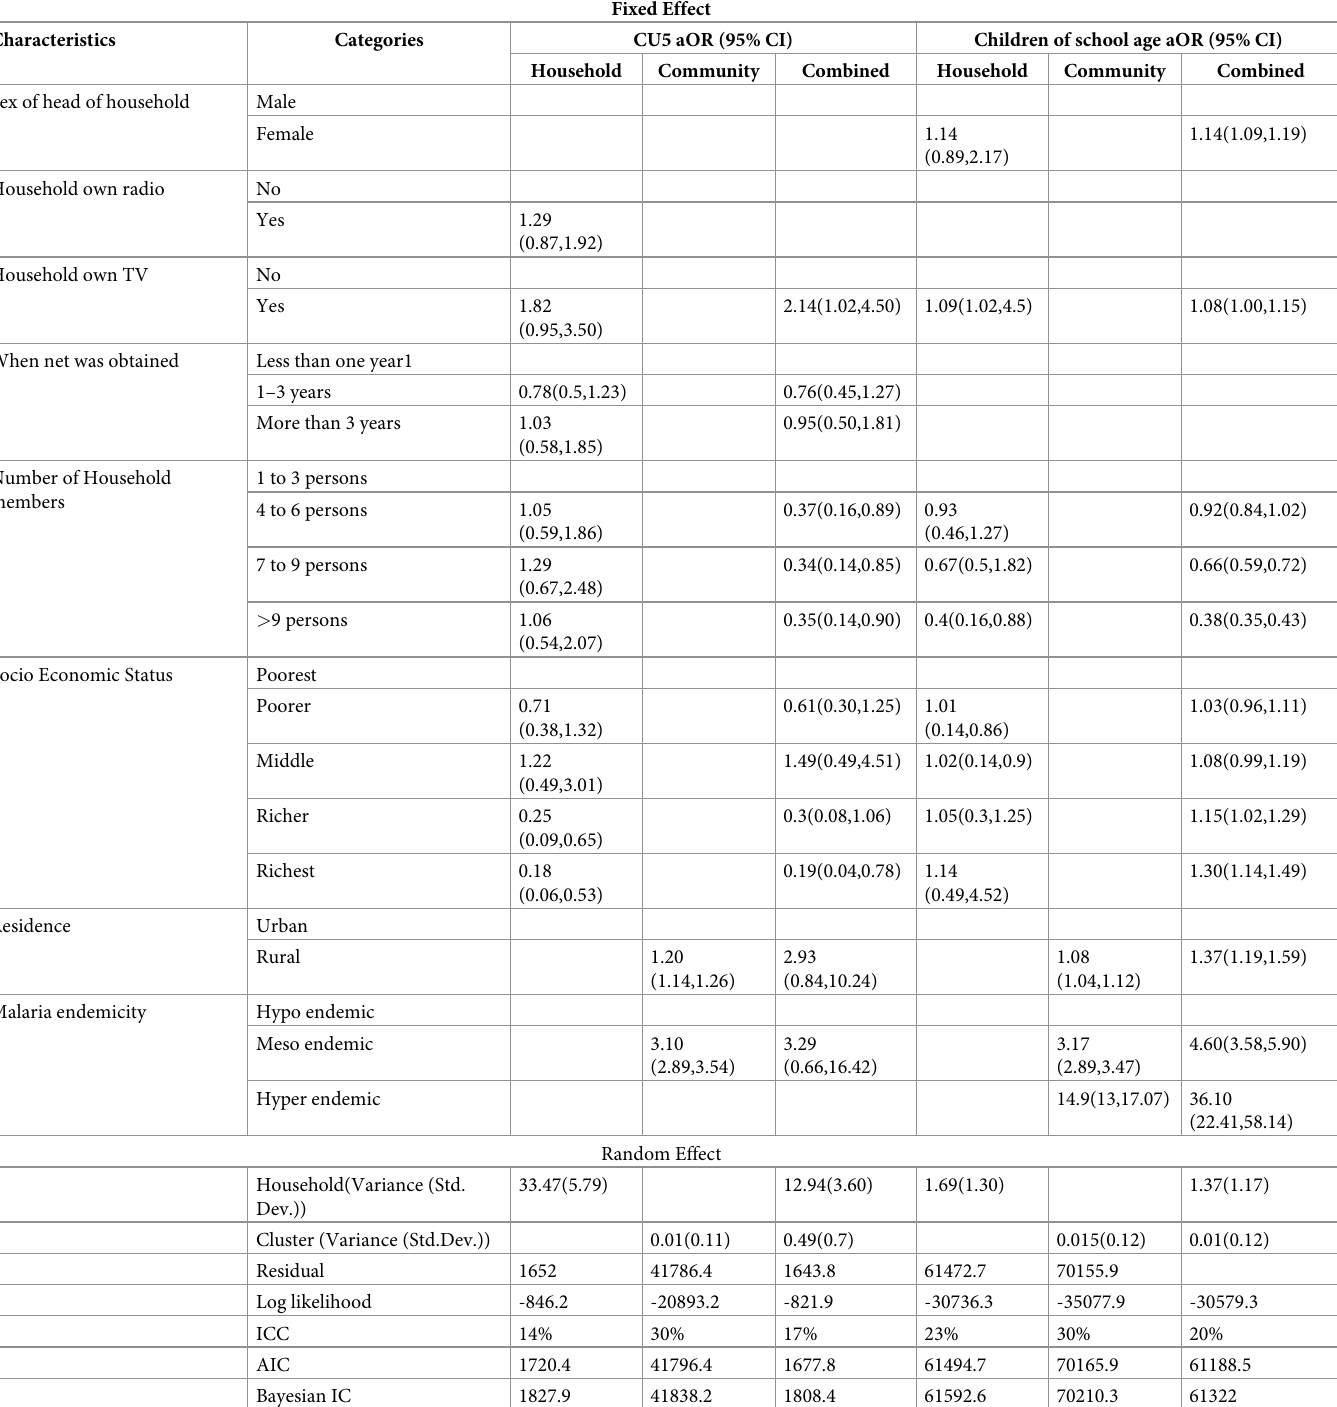
Table 3. Multilevel logistic regression on socio and demographic factors associated with ITN use in CU5 and children of school age in households owning at least one